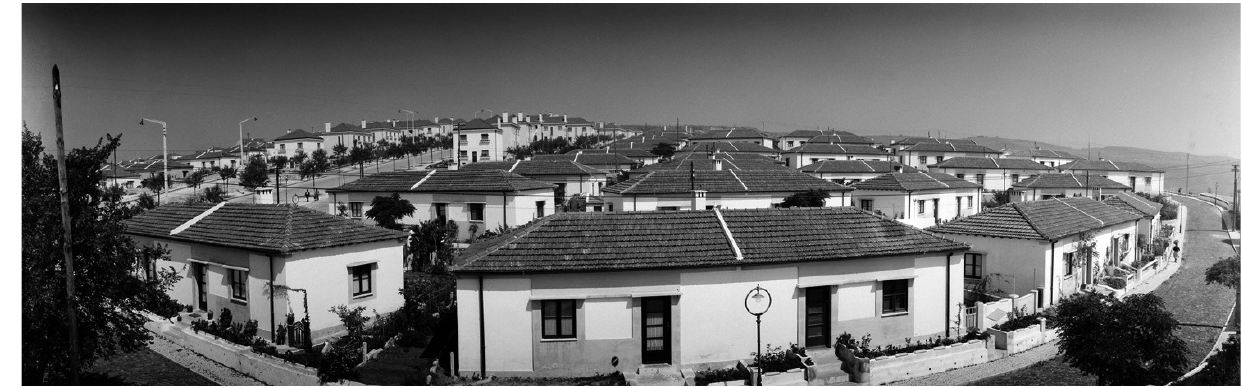
Figure 2. Alto da Ajuda (Lisbon) affordable housing estate: Phase 1, 1934–1938 (reference a223 in Mapa da Habitação [MdH] database). Source: Novais